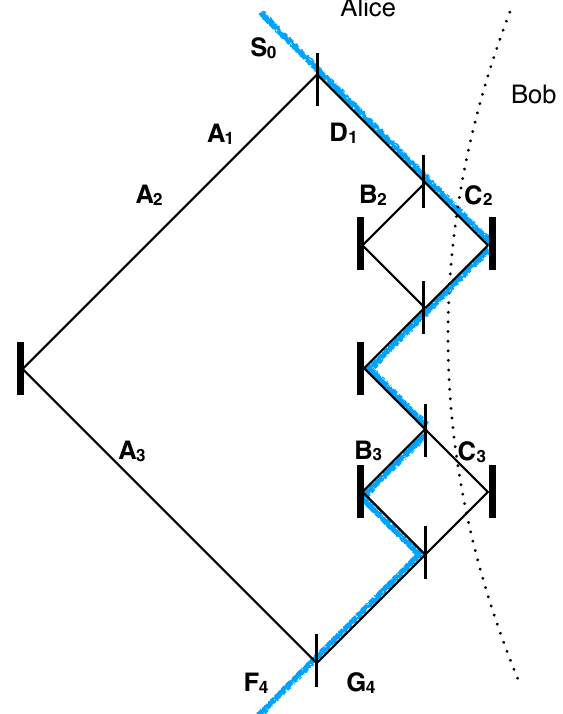
Fig. 5 Aharonov and Vaidman ’ s protocol overlaid with a counterfactuality-violating history. The modi fi ed protocol pro- posed by Aharonov and Vaidman in ref. 11 , of which we show one cycle, cannot be said to be counterfactual from a consistent histories viewpoint. This can be seen from the series of projections, or history, highlighted in blue. The thin vertical lines represent non-polarising beamsplitters, thick vertical lines represent mirrors, and the blue path shows an example of a history where, when Bob doesn't block, the photon travels to Bob and back to Alice ’ s relevant detector with nonzero probability. See text for mathematical